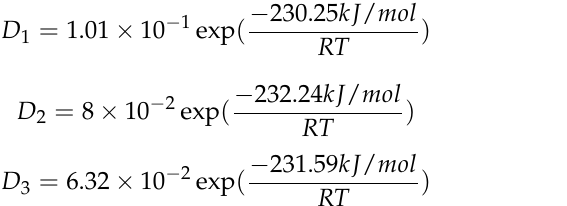
In Figure 3 are plotted the fitted values of Table 4 with Arrhenius relationships based on the MDC method. The results of this regression were given by Equations (29)– (31):